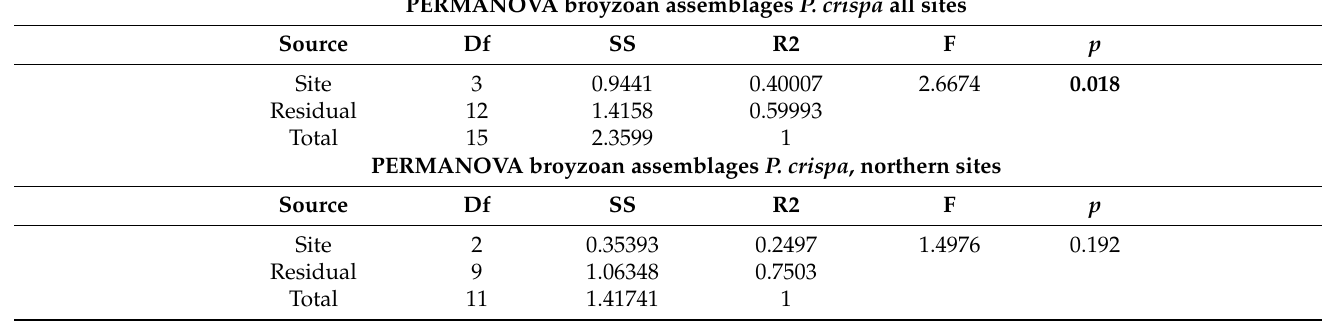
Figure A1. Diver assessing Phyllophora crispa mat on site PC2. The picture shows the typical closed coverage of Phyllophora crispa across the rocky surface of all sampling sites (Picture: F. I. Rossbach). Table A1. Results of permutational multivariate analysis of variance (PERMANOVA) of bryozoan communities among P. crispa sites, and pairwise comparison (Tukey’s honestly significant difference (HSD) test) of sites and (sub-) habitats. Significant results ( p < 0.05) are indicated in bold. PERMANOVA Broyzoan Assemblages P. crispa All Sites